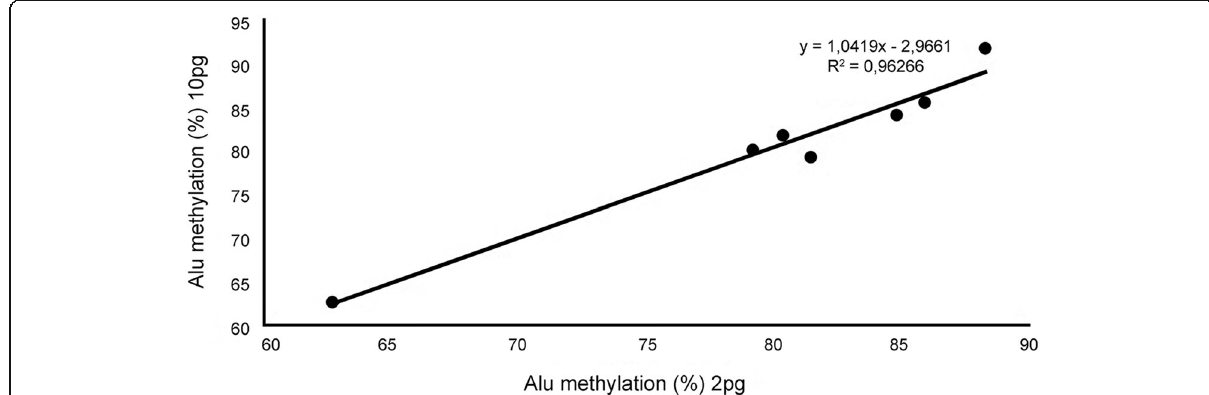
Fig. 1 Coefficient correlation of Alu methylation levels in different amounts of gDNA (10 or 2pg of genomic DNA for well) of 7 of 10 CLL samples. For 3 CLL samples, positive droplets saturation was observed starting from